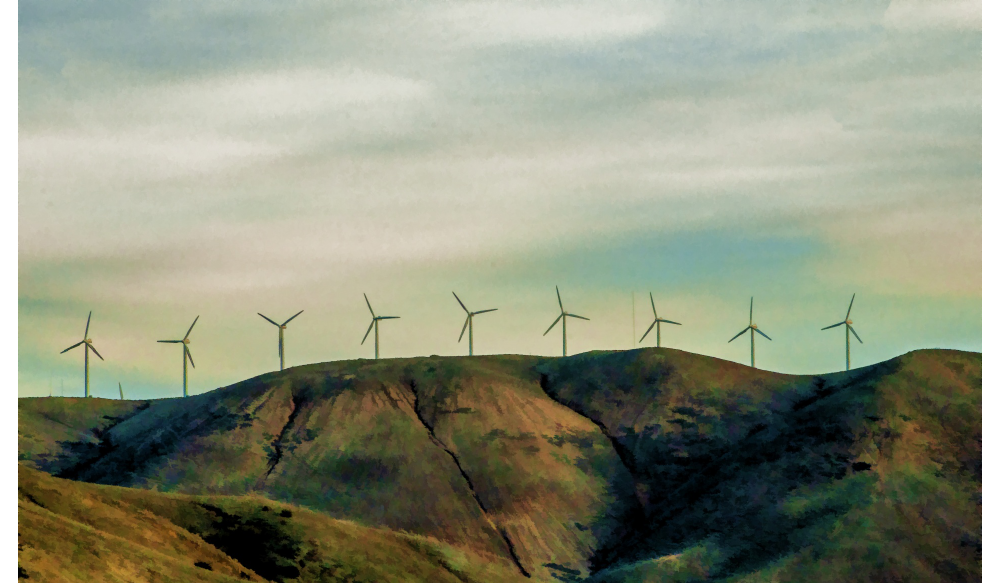
Figure 3. View on one of the wind farms. Source